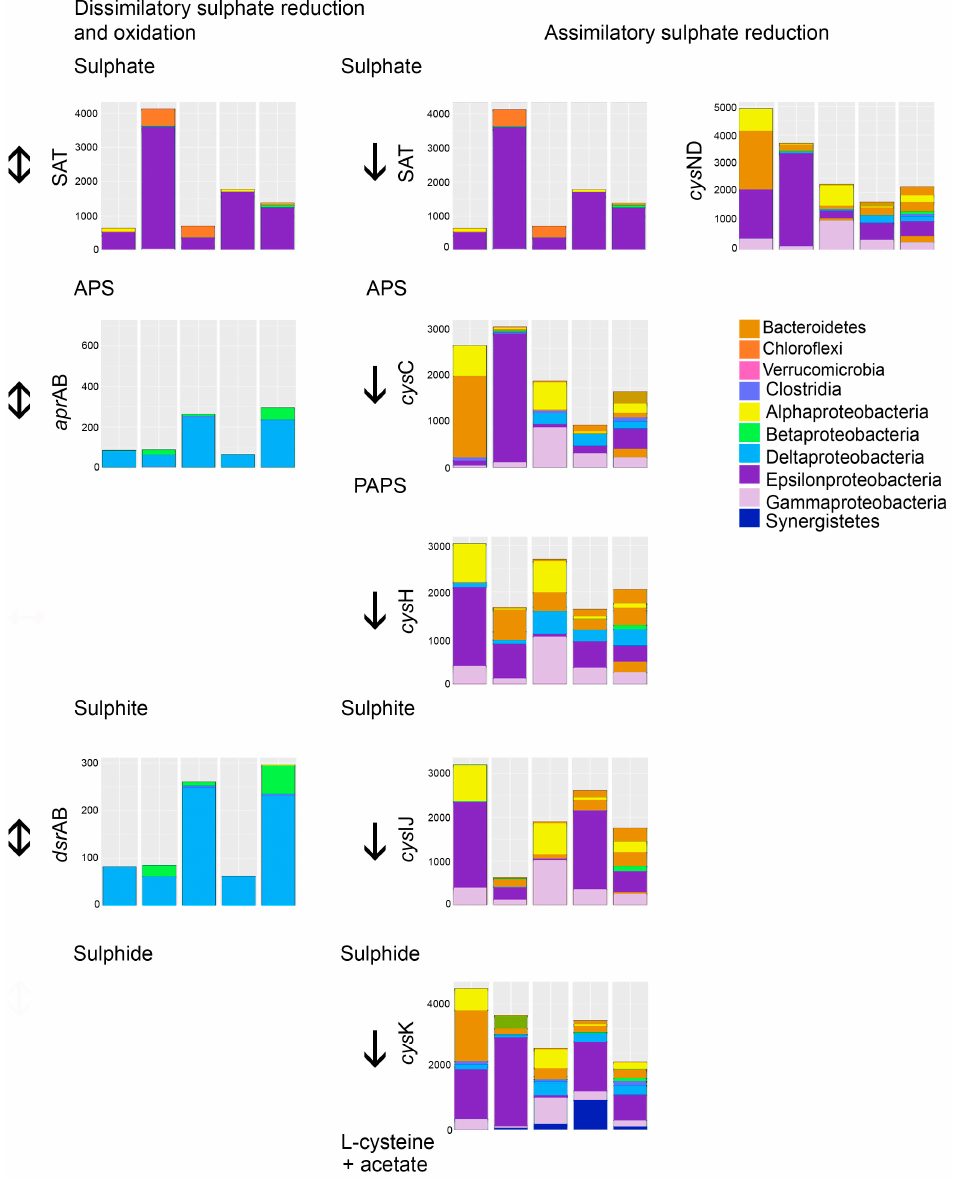
Figure 5. The bacterial groups responsible for the different steps of biological sulfate reduction processes in the bioreactors. Acetate is produced in the reaction where L -cysteine is produced from hydrogen sulfide + Pyruvate + ammonia. The Y -axis shows the number of sequence reads detected. The taxonomic groups are shown by the color charts in each figure. SAT—sulfate adenylyltransferase, apr AB—adenylylsulfate reductase, subunit A and B, dsr AB—dissimilatory sulphite reductase, subunit A and B, cys ND—sulfate adenylyltransferase subunit N and D, cys C—adenylylsulfate kinase, cys H—phosphoadenosine phosphosulfate reductase, cys IJ—assimilatory sulphite reductase (NADPH dependent), cys K—cysteine synthase A. The columns in each chart from the left; BR1 day 101, BR1 day 140, BR2 day 101, BR3 day 101, BR3 day 140.